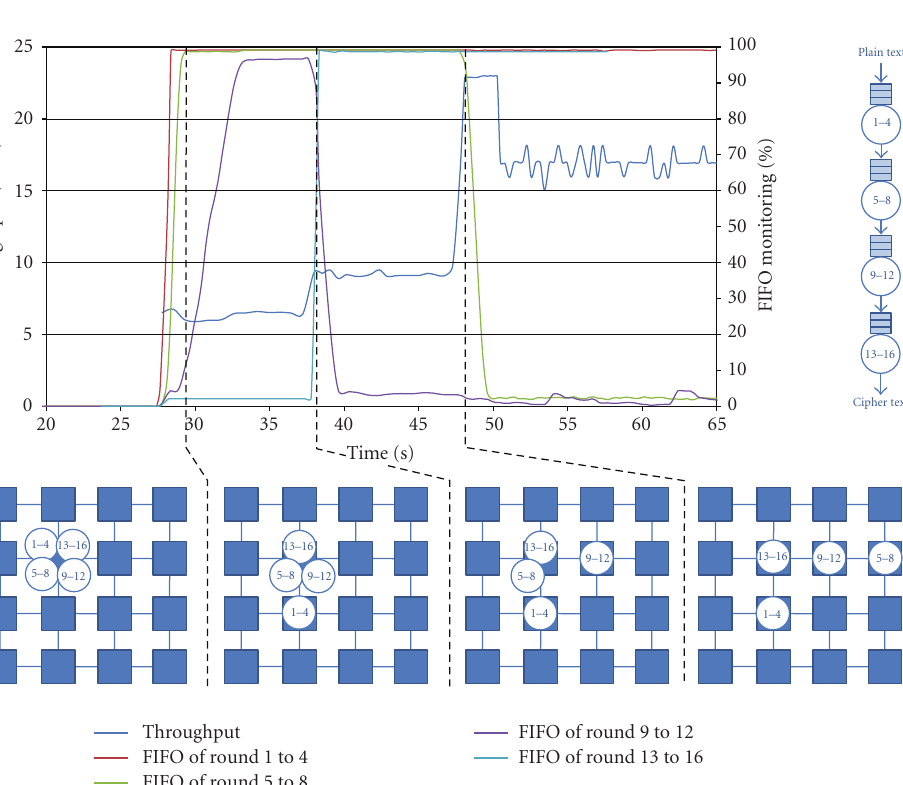
Figure 21: DES4 execution in time with